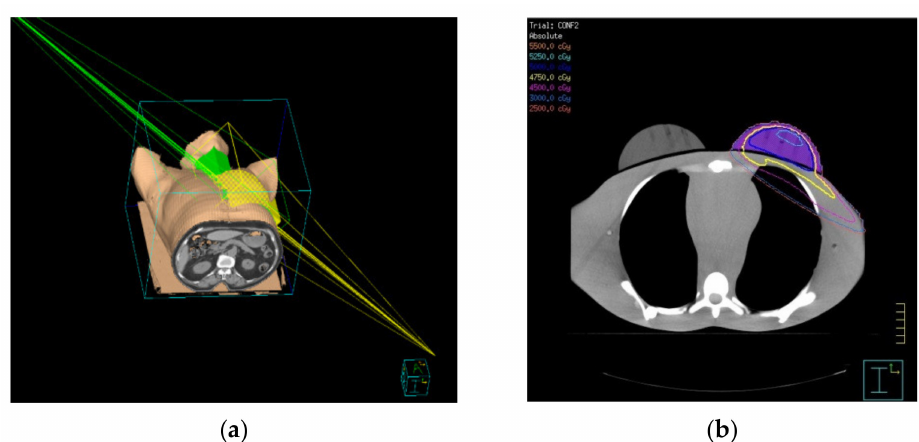
Figure 1. Treatment planning using Tangential 3D conformal radiotherapy (3D-CRT) ( a ) Whole breast irradiation scheme (2 fields). ( b ) Dose distribution image. Yellow planning targeting area, purple tumor bed.